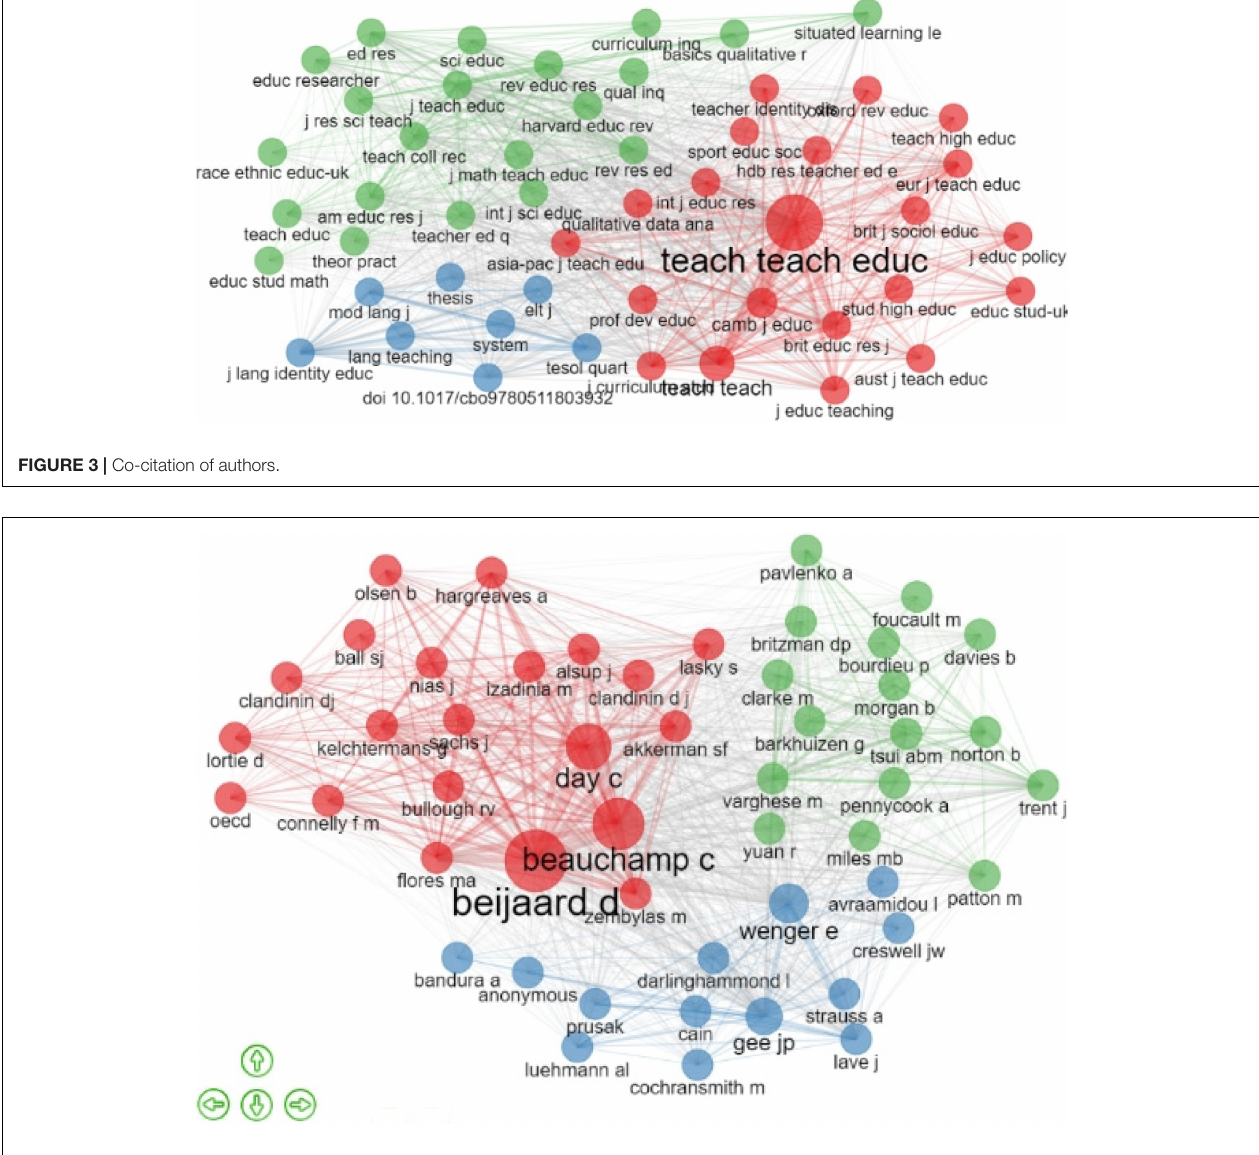
FIGURE 4 | Co-citation of